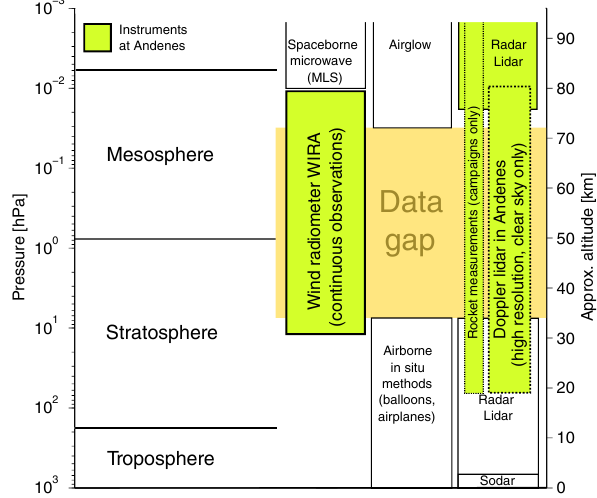
Figure 1. Overview of the altitude coverage of the currently op- erational wind measurement techniques. The techniques available at Andenes (69.3 ◦ N, 16.0 ◦ E), the observation site of the present study, are